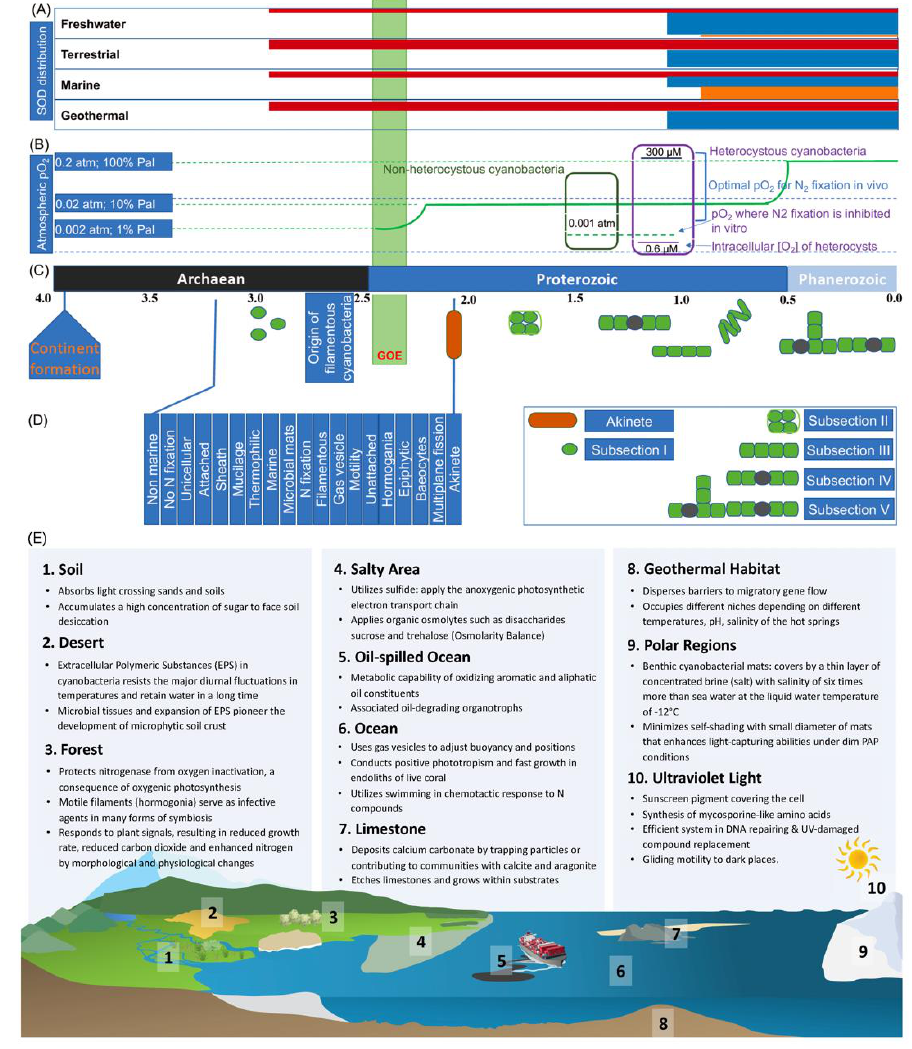
Figure 1. The evolutionary trajectory of cyanobacteria in the presence of oxygen and adaptive radiation: ( A ) The origin and distribution of SODs in different habitats. The timing of origin and habitat distribution of SOD genes among taxa is created based on Boden et al. [24]. Starting points of horizontal bars represent time of origin and color SOD types: CuZnSOD (blue), NiSOD (green), and Fe- and Mn-utilizing SODs (yellow). ( B ) The oxygen level in atmosphere and nitrogen fixation in heterocysts in cyanobacteria in the presence of elevated oxygen levels. The level of oxygen is based on [34]. ( C , D ) The temporal morphological diversification of cyanobacteria is based on Schirrmeistera et al. [27]. ( E ). Adaptive strategies of cyanobacteria in different habitats. Cyanobacterial adaptation strategies in nine environments, namely, soil, desert, forest, salty area, oil-spilled ocean, open ocean, limestone, geothermal water, and polar region. Cyanobacteria also cope with the damage caused by ultraviolet light.